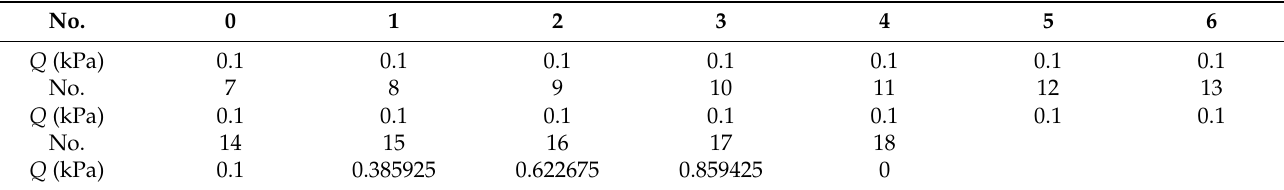
Table 2. Construction load on each girder section